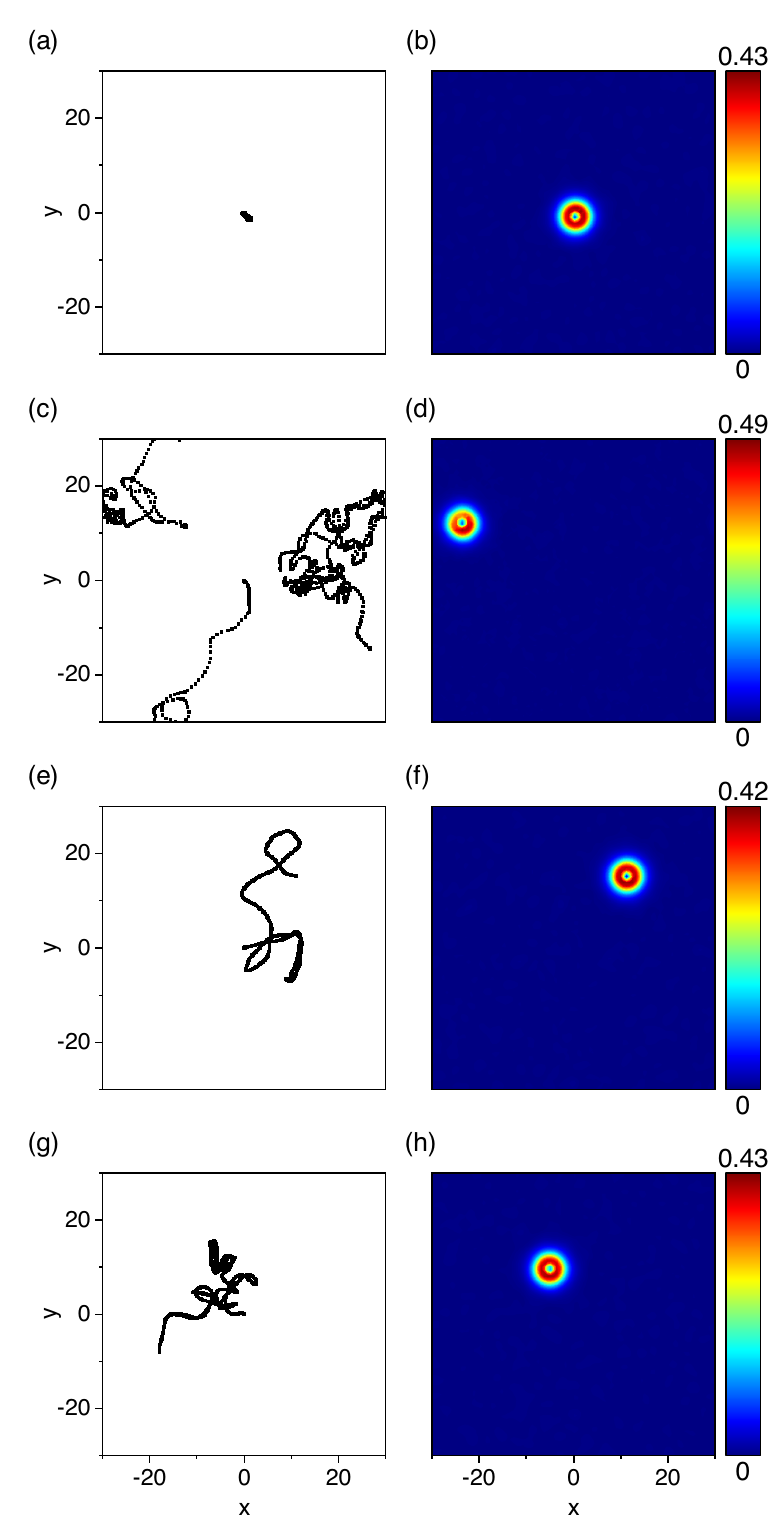
Fig. 7 Robustness of the bulk solitons. Robustness of the bulk soliton with the frequency ω = 9.35 at K valley under the self-focusing nonlinearity, when ±5% disorders are added to the nonlinear parameter g and saturation coef fi cient σ ( a ), ( b ), on-site energies ω A ; B ( c ), ( d ), nearest-neighbor (NN) hopping t 1 ( e ), ( f ), and next-nearest-neighbor (NNN) hopping t ( g ), ( h ), respectively. a , c , e , and g show the trajectories of the soliton centers under the temporal 2 evolution; and b , d , f , and h show the amplitudes of the pseudospin component ψ at the output wi t h t = 10,000. The color bars in b , d , f , and h denote the 1